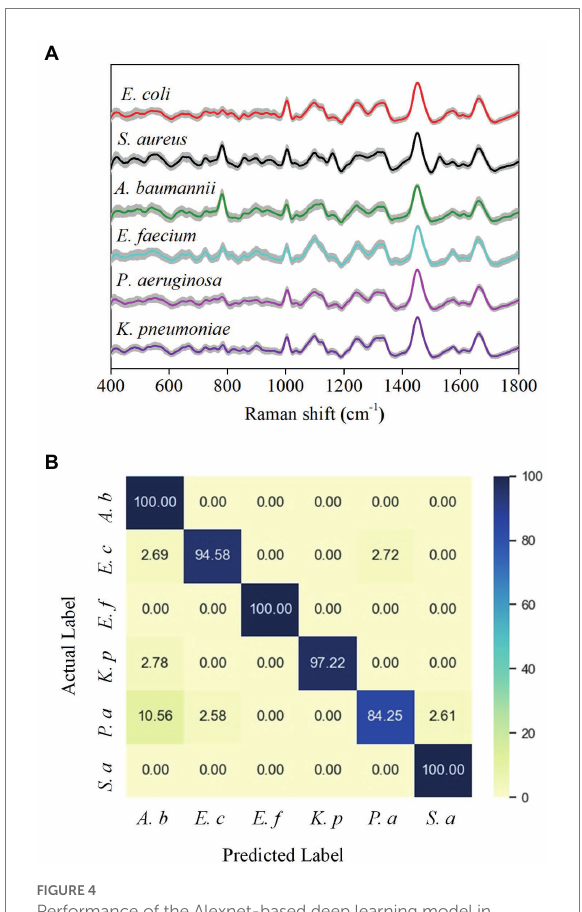
FIGURE 4 Performance of the Alexnet-based deep learning model in bacterial identification. (A) Average Raman spectra of six common bacteria in UTI. The gray area represents the standard deviation of the spectra. (B) Confusion matrix of bacterial classification (values are listed as percentages).